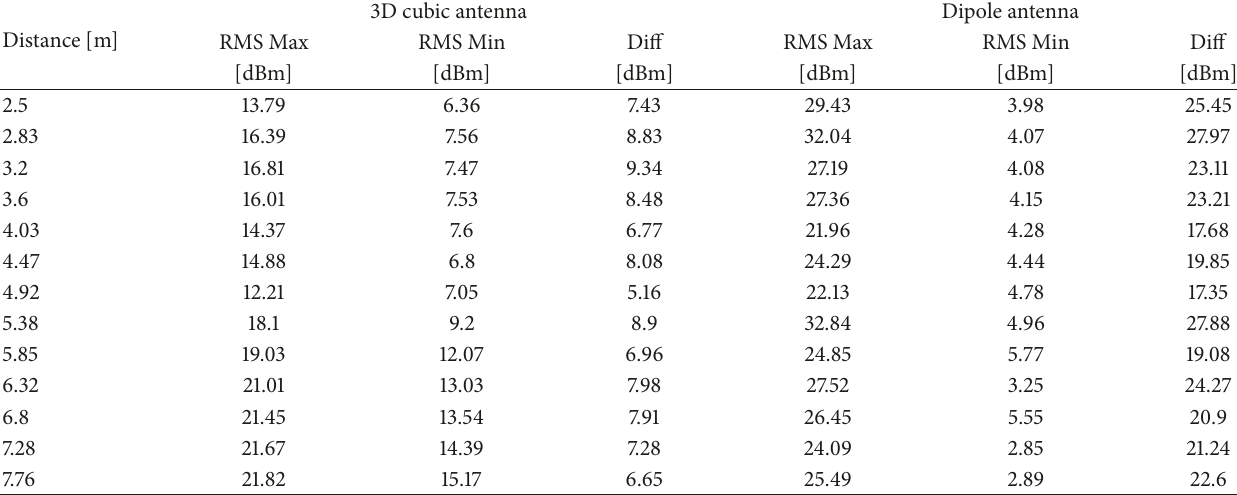
Table 8: Difference between RMS Max and Min in the OLOS